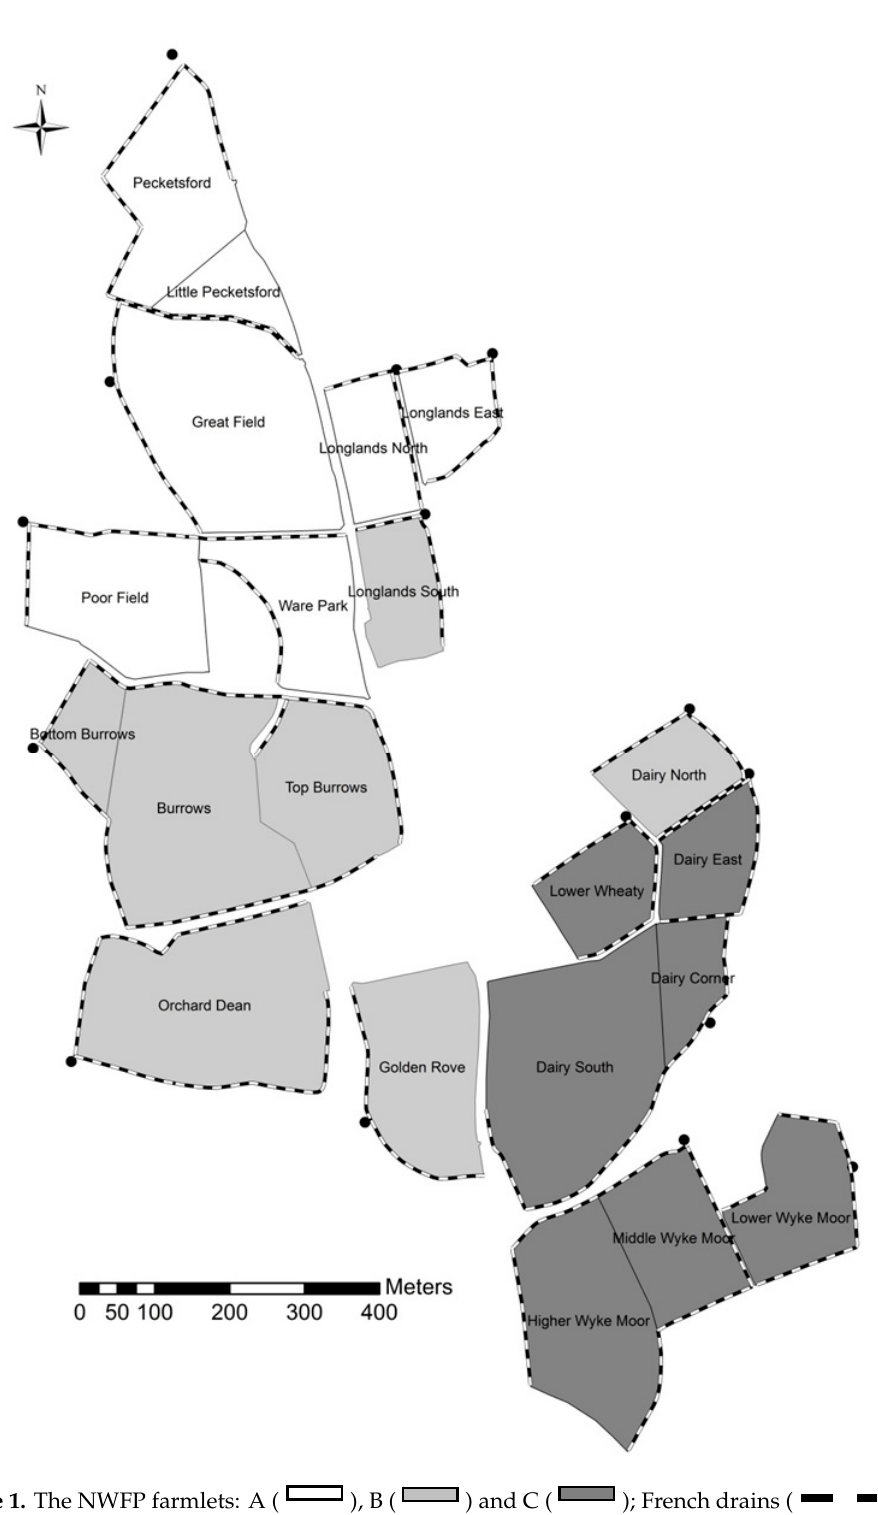
Figure 1. The NWFP farmlets: A ( ), B ( ) and C ( ); French drains ( ) and water monitoring sites ( ). Weather data were recorded every 15 min with an automatic met station installed on-site. Total annual rainfall for 2011 was 835 mm and for 2012 was 1046 mm. Solar radiation for 2011 and 2012 is shown in Figure